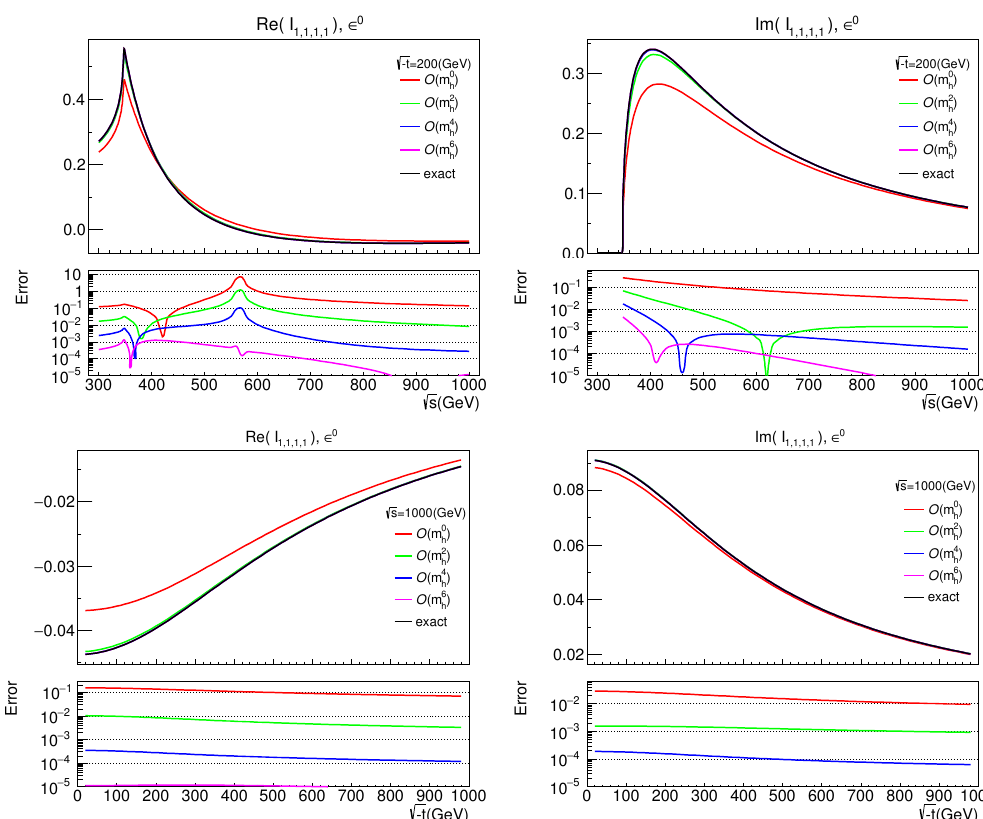
Figure 2 . The real part (left plots) and the imaginary part (right plots) of the order (cid:15) 0 coe(cid:14)cient p of the one-loop integral I 1 ; 1 ; 1 ; 1 . The upper plots (cid:12)x (cid:0) t = 200 GeV and show the integral as a p p function of s , while the lower plots (cid:12)x s = 1000 GeV and show the integral as a function of In the lower panels of each plot, we show the relative errors of the approximate results against the exact result (see also the text for de(cid:12)nition). The integral has been multiplied by m 4